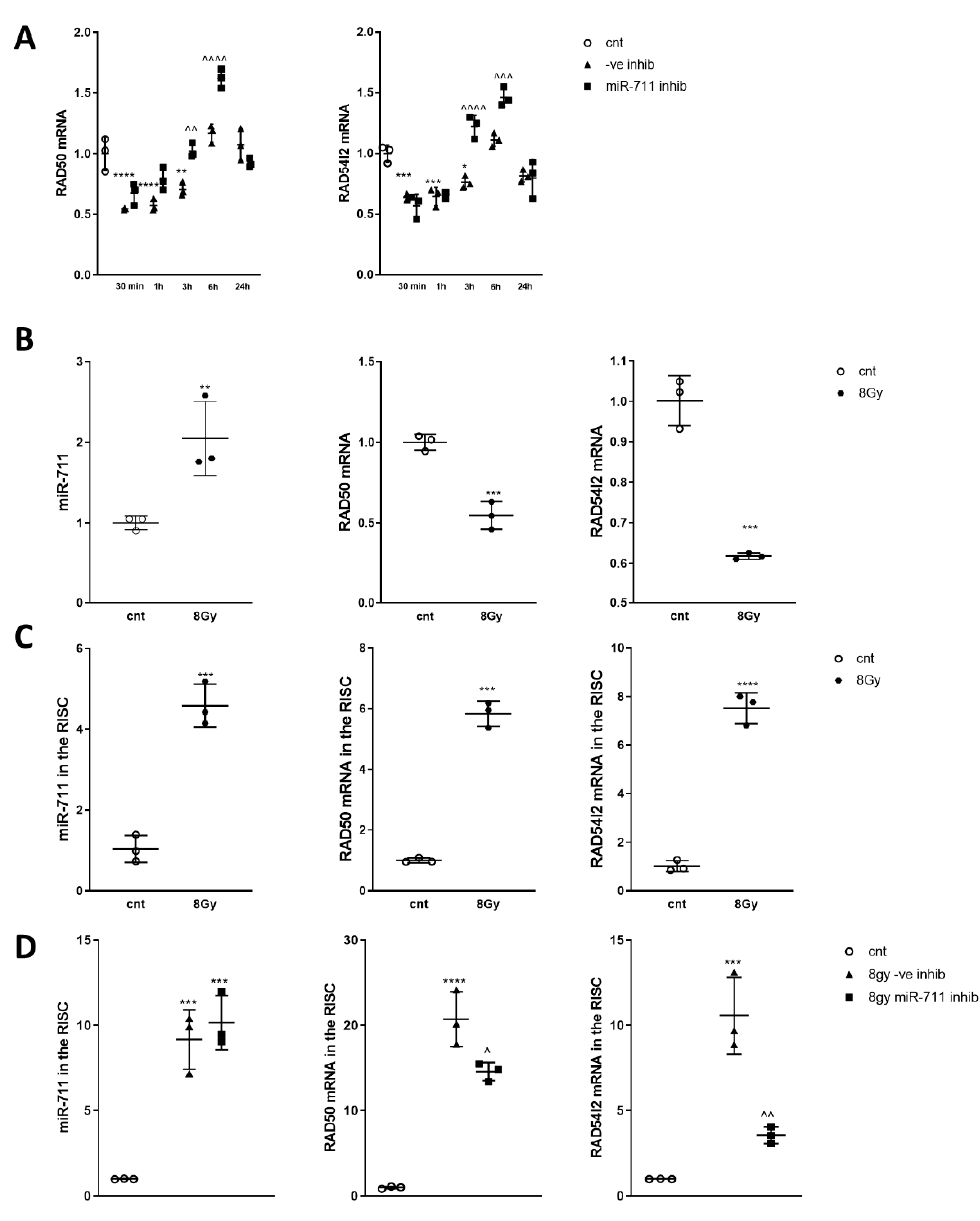
Figure 8. miR-711 inhibition attenuates irradiation-induced downregulation of DNA repair molecules Rad50 and Rad54l2. qPCR quantification of RAD50 and RAD54l2 ( A ). Rad50 mRNA (F(10,22) = 43.49, p < 0.0001 at 30 min and 1 h, p = 0.0082 at 3 h after IR with miR-ve inhibitor, compared to control; for miR-711 inhibitor, compared to miR-ve inhibitor, p = 0.0039 at 3 h, p < 0.0001 at 6 h). Rad54l2 mRNA (F(10,22) = 39.1, p = 0.0005 at 30 min, p = 0.006 at 1 h, p = 0.0396 at 3 h after IR with miR-ve inhibitor, compared to control; for miR-711 inhibitor, compared to miR-ve inhibitor, p < 0.0001 at 3 h, p = 0.0007 at 6 h). n = 3 / group for all groups, * p < 0.05, ** p < 0.01, *** p < 0.001, **** p < 0.0001 vs. control; ˆ p < 0.05, ˆˆ p < 0.01, ˆˆˆ p < 0.001, ˆˆˆˆ p < 0.0001 vs. corresponding 8Gy + miR-ve inhibitor group. RCNs were exposed to 8Gy and, after 3 h, cells were collected and lysed. One part of the lysate from each sample was used for RNA isolation and qPCR analysis for levels of miR-711, RAD50 and RAD54l2 ( B ). miR-711 (T(4) = 3.856, p = 0.0091), Rad50 mRNA (T(4) = 7.944, p = 0.0007), Rad54l2 mRNA (T(4) = 0.74, p = 0.0002). The other part was subjected to RIP using Ago2 antibodies, followed by qPCR analysis for levels of miR-711, RAD50 and RAD54l2 in the RISC ( C ). miR-711 (T(4) = 9.77, p = 0.0003); Rad50 mRNA (T(4) = 9.55, p < 0.0001); Rad54l2 mRNA (T(4) = 16.8, p < 0.0001). n = 3 / group. Significance assigned by one-tailed t-test, *** p < 0.001, **** p < 0.0001 vs. control RCNs. This experiment was repeated